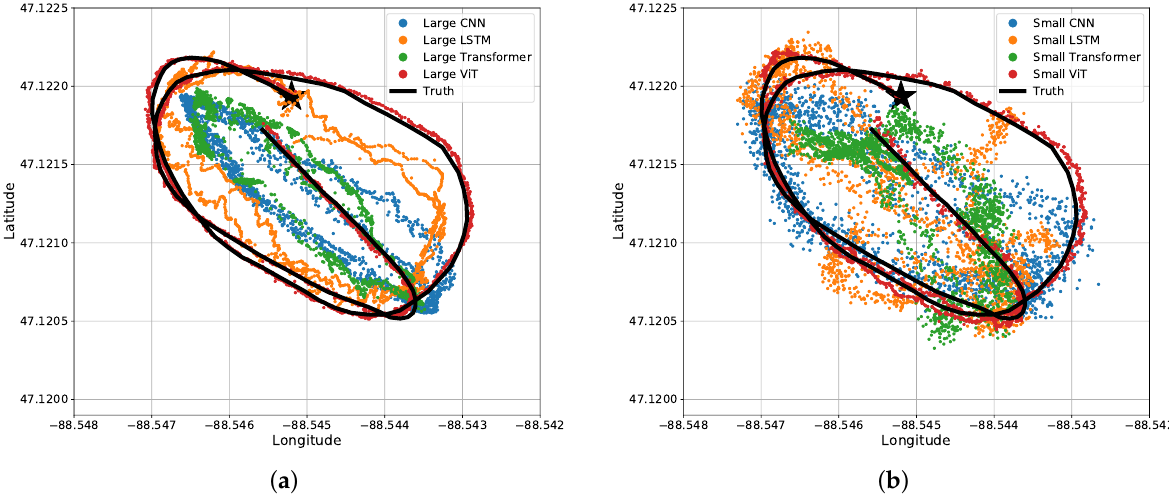
Figure 12. Bird’s eye view of results for the four different ( a ) large regression algorithms and ( b ) small regression algorithms. The same data and predictions from Figure 11 are